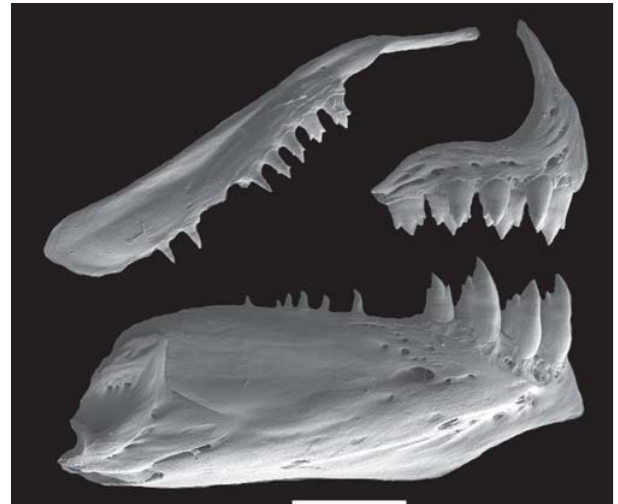
Fig. 20. Hemibrycon polyodon , KU 20004, female, 52.5 mm SL. Scale bar = 1